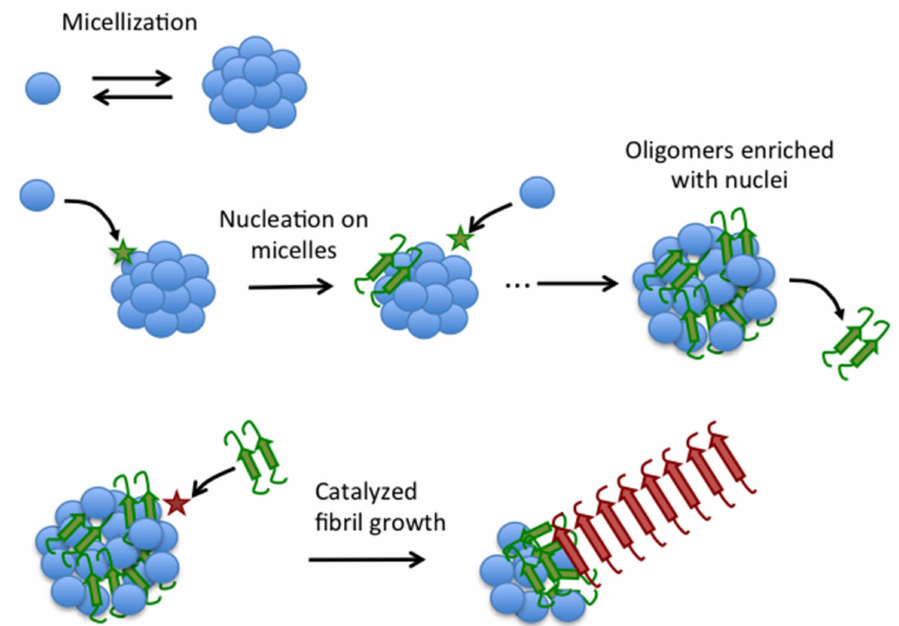
Figure 10. Schematic illustration of the novel autocatalytic mechanism of fibrillation of A β 40. Blue balls represent disordered A β 40 monomers in equilibrium with micelles. Aggregation nuclei (green) form by monomer collision with the micelles (star) and remain embedded in the micelles to form type-A oligomers, which can release nuclei to the bulk solution. Nuclei can then catalyze fibrillation on type-A oligomers to form mature fibrils